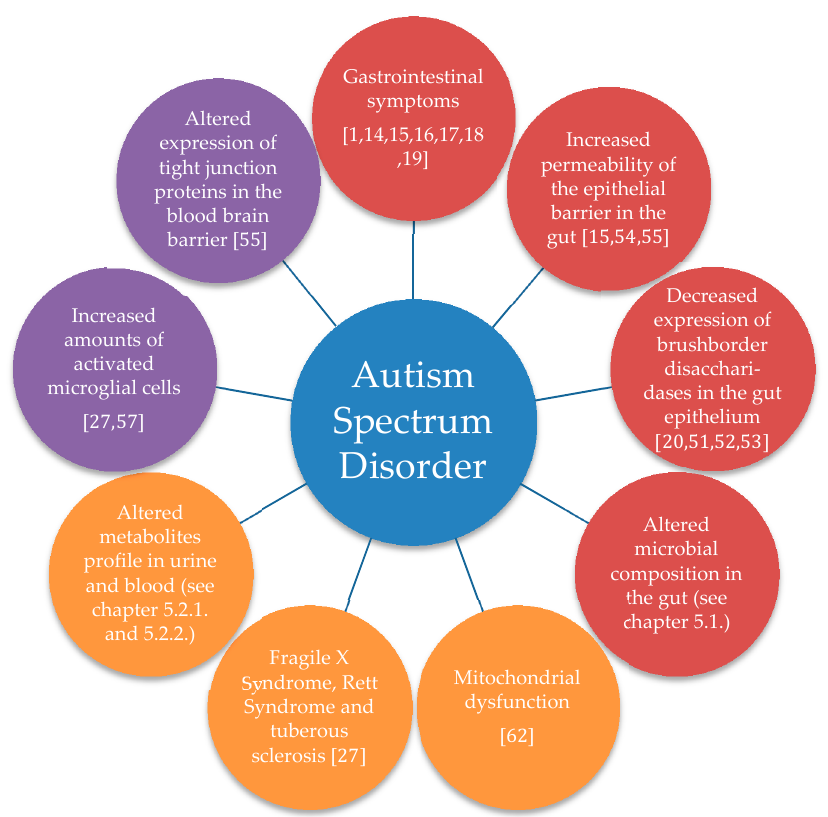
Figure 2. Co-occurring pathologies found in Autism Spectrum disorder (ASD). Red shows gut-related comorbidities found in ASD, purple shows brain-related comorbidities and orange other comorbidities. Chapter 3 gives more information to the mentioned comorbidities.